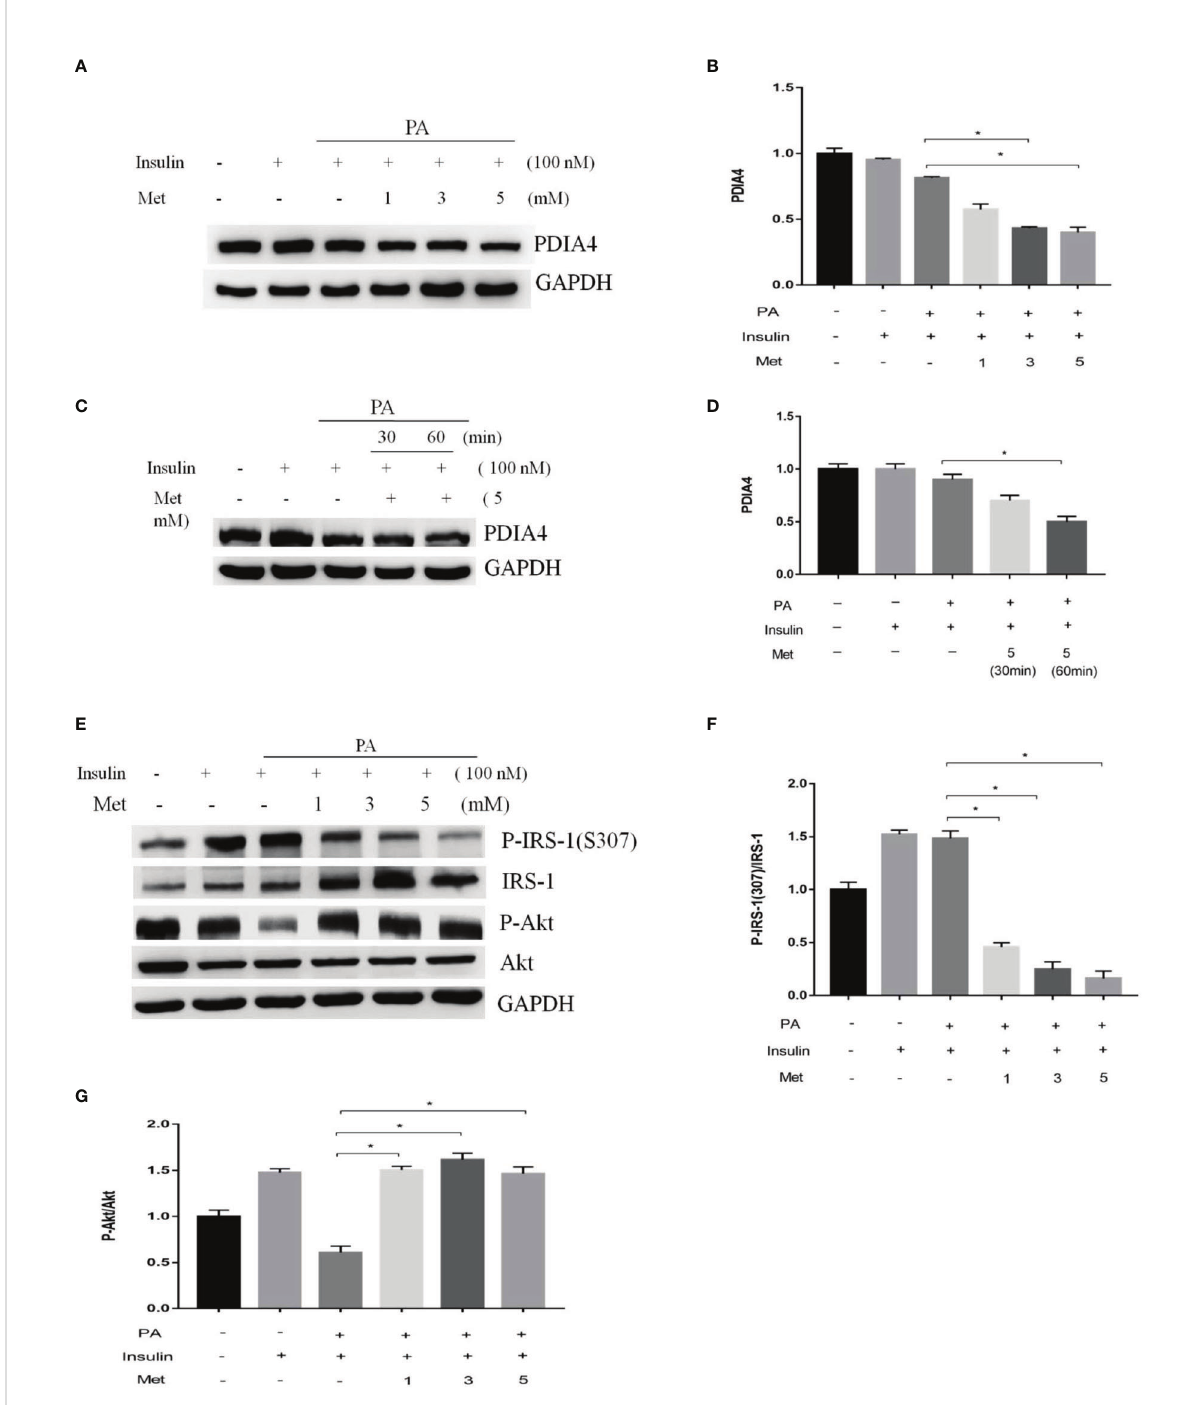
FIGURE 4 Metformin modulated PDIA4 expression and palmitate-induced IR in C2C12 cells. (A, B) The C2C12 myotubes treated 1,3,5 mM metformin with 100 nM insulin, then estimated PDIA4 expression by western blotting. (C, D) The C2C12 myotubes treated 5 mM metformin with palmitate and insulin, then estimated PDIA4 expression by western blotting. (E – G) The C2C12 myotubes treated 1,3,5 mM metformin with palmitate and insulin, then estimated p-IRS-1(307), p-Akt by western blotting. All data are presented as the mean ± SD (n = 3 for each group). *P <